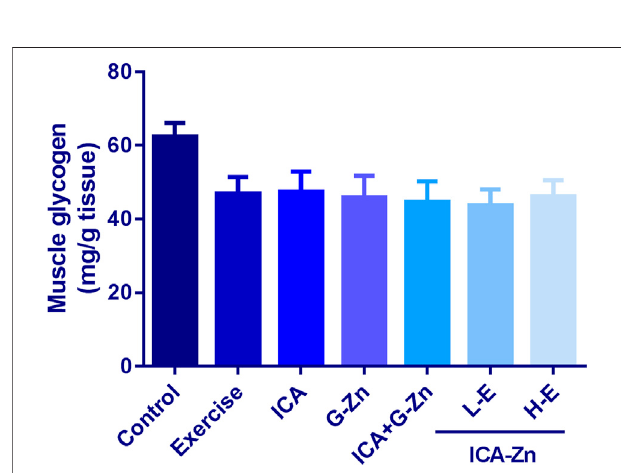
FIGURE 5 | Effect of icariin-zinc on muscle glycogen level in rats ( n (cid:2) 8, mean ±